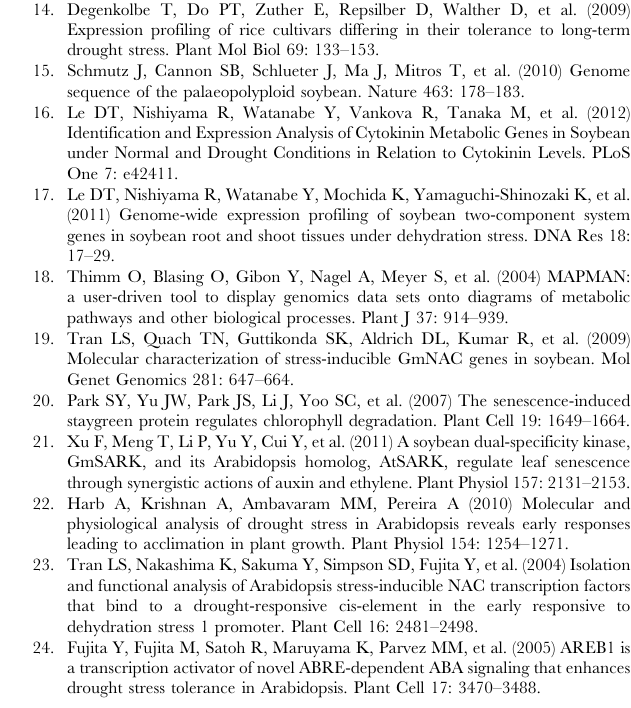
Table S2 Expression data of annotated soybean genes in R2 leaves under drought stress. Data received from microarray analysis of drought-stressed R2 leaves using the 66 K Affymetrix Soybean Array GeneChip. Table S3 Differential expression data of soybean genes in V6 leaves under drought stress. (A) Numbers of genes on the 66 K Affymetrix Soybean Array GeneChip that could be annotated. (B) Microarray analysis of genes that are annotated with a function. (C) List of upregulated genes which have an annotated function. (D) List of downregulated genes which have an annotated function. (XLSX) Table S4 Differential expression data of soybean genes in R2 leaves under drought stress. (A) Numbers of genes on the 66 K Affymetrix Soybean Array GeneChip that could be annotated. (B) Microarray analysis of genes that are annotated with a function. (C) List of upregulated genes which have an annotated function. (D) List of downregulated genes which have an annotated function. Table S5 Differential expression of hormone-related genes in soybeanV6 and R2 leaves under drought